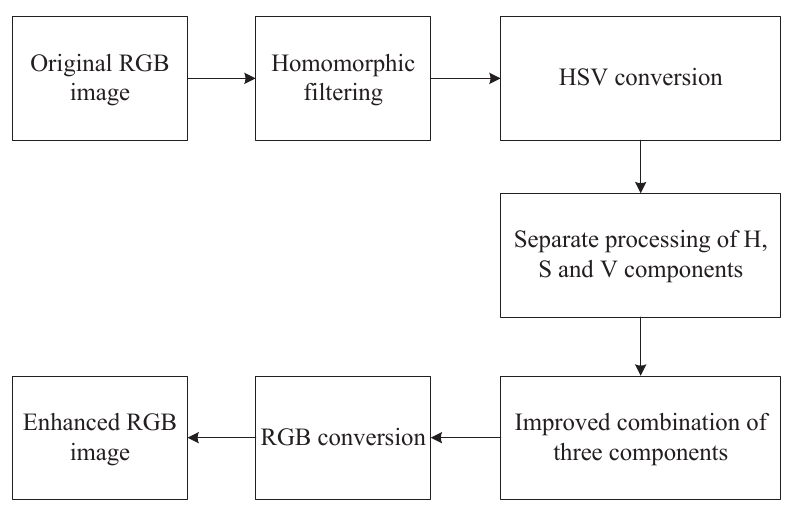
Figure 2. Overall flow